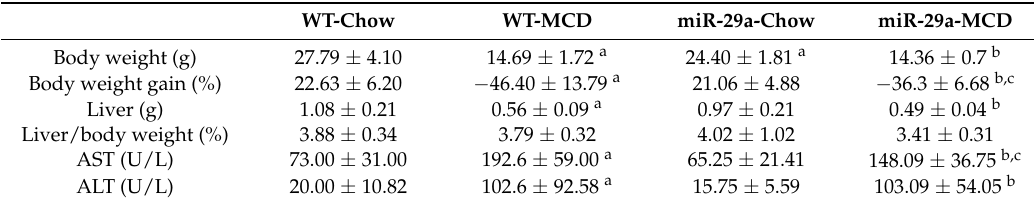
Figure 1. Overexpression of miR-29a significantly reduced hepatocellular steatosis and fibrosis in methionine-choline-deficient (MCD) diet mice. The hematoxylin and eosin stain showed an abundance of fat droplets accumulated in the liver after feeding WT mice the MCD diet for 4 weeks ( A , B , p < 0.001). Compared to the WT littermates, miR-29a overexpression reduced the abundance of fat droplets accumulated in the livers of miR-29aTg mice ( A , B , p < 0.001). Furthermore, Sirius red stain and western blot demonstrated a greater accumulation of extracellular matrix ( C , D ) and α -SMA expression ( E ) in the livers of WT-MCD mice compared to WT-Chou (both p < 0.001). However, miR-29a-MCD mice showed a weaker induction of collagenous matrices and α -SMA compared to WT-MCD mice ( p < 0.001 and p = 0.024, respectively). Data are expressed as the mean ± SD of six to eight samples per group. * indicates a p < 0.05 between the groups. Table 1. Comparison of the changes in the four